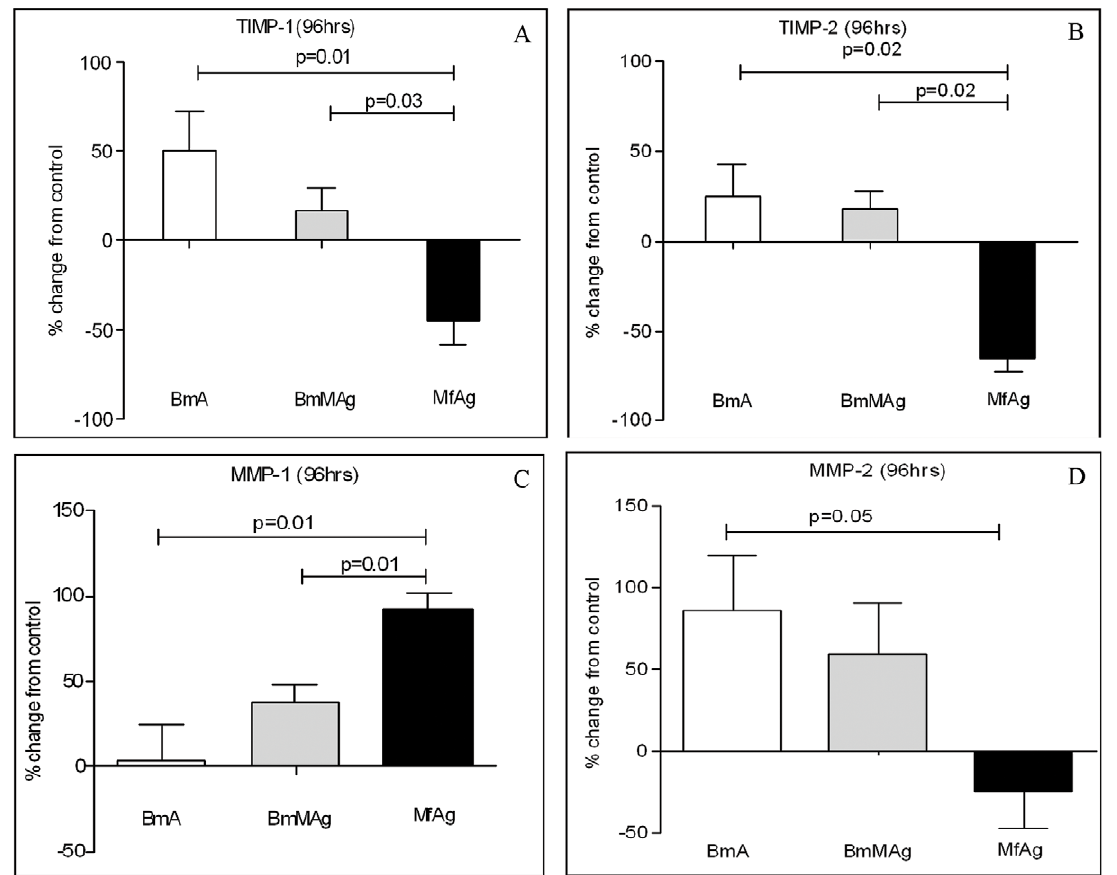
Figure 6. Filarial antigens induce metalloproteases MMP-1 and MMP-2. Shown are the levels of TIMP-1 (Panel A) and TIMP-2 (Panel B), MMP- 1 (Panel C) and MMP-2 (Panel D) upon stimulation with various filarial antigens. Data are expressed as the mean ( + 95% CI) % change from control (media) for 3 independent experiments.